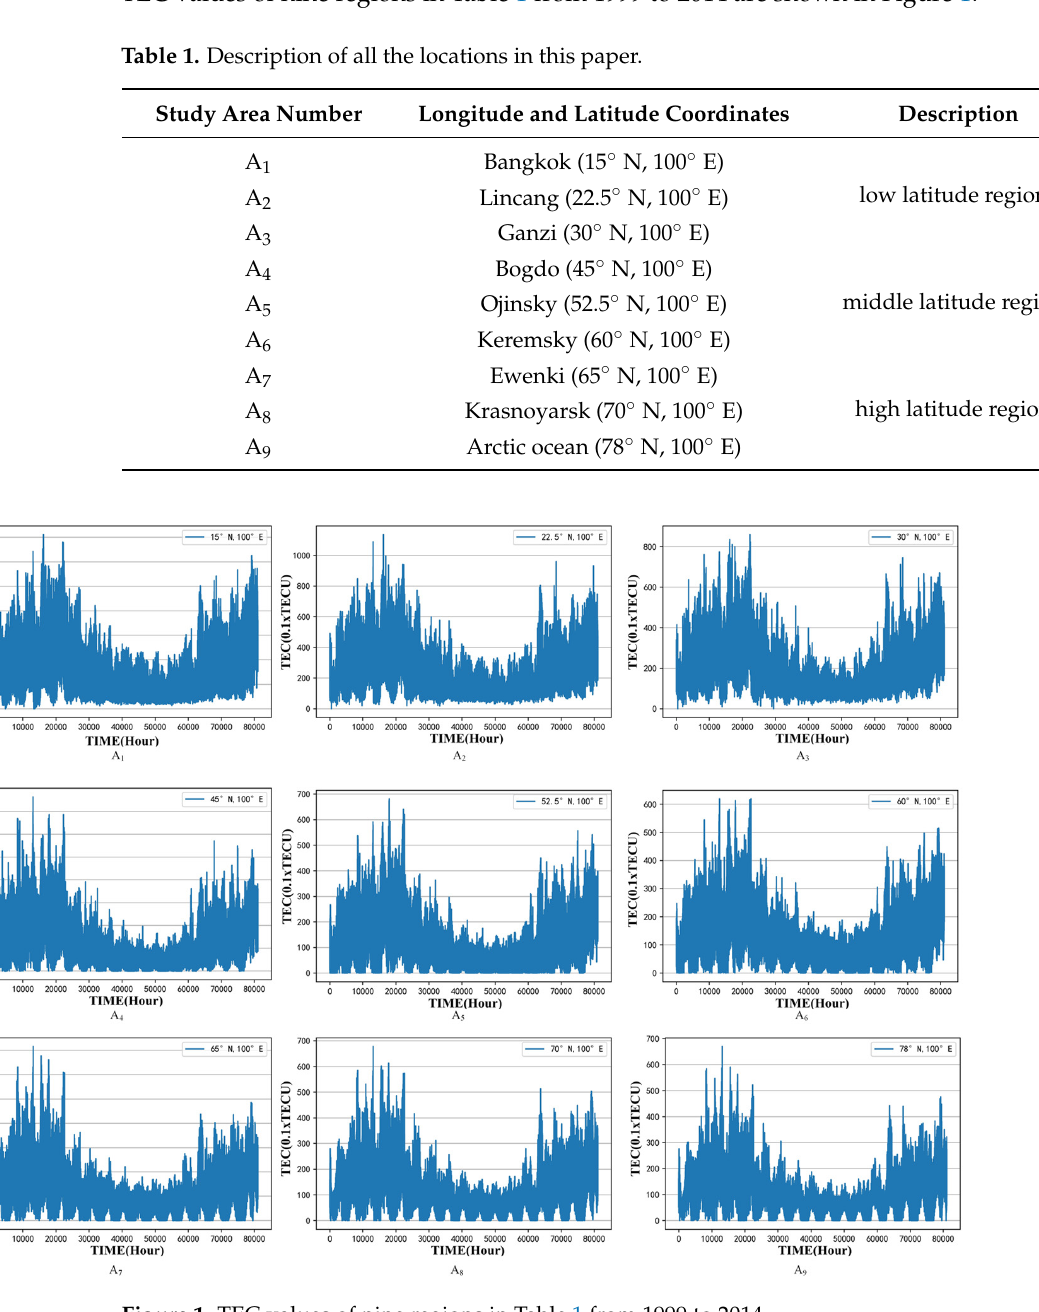
Figure 1. TEC values of nine regions in Table 1 from 1999 to